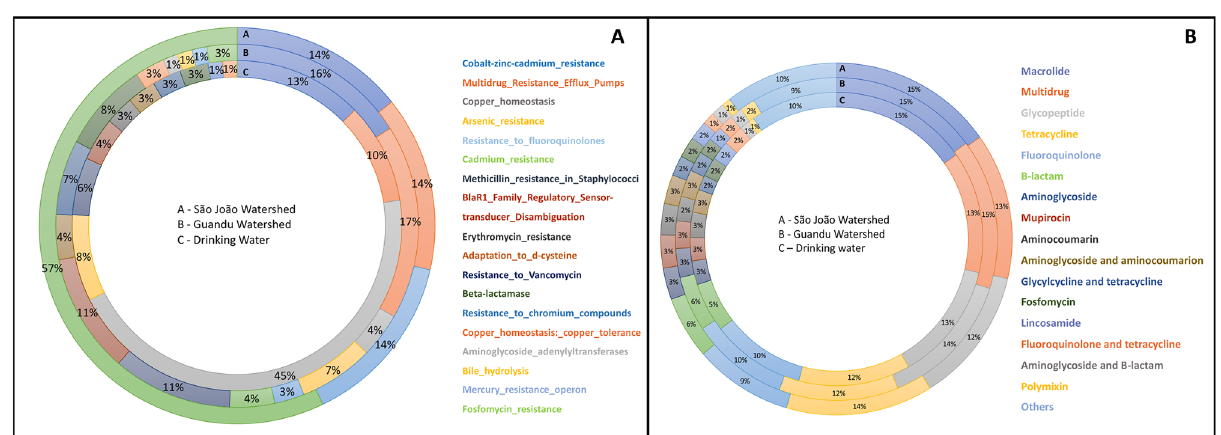
Figure 4. ( A ) Relative abundance of sequences related to antimicrobial resistance subsystems and toxic compounds in grouped samples of São João watershed, Guandu watershed, and Drinking water; ( B ) Relative abundance of ARGs concerning antimicrobial classes, in the three groups of